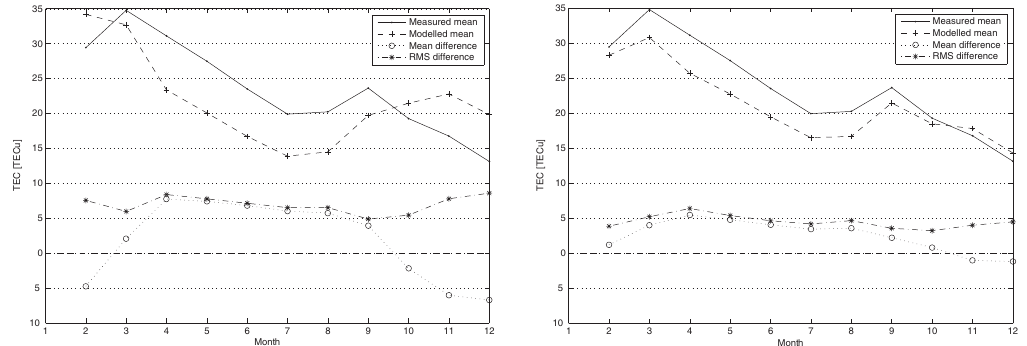
Fig. 1. Comparison between NeQuick version 1 (left) and 2 (right) and GPS vertical TEC in 2002: monthly